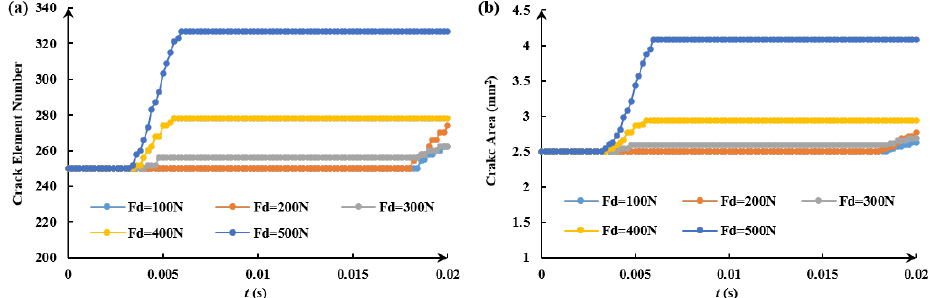
Figure 14. Fracture degree of the crack under different amplitudes of dynamic load: ( a ) crack element number; ( b ) crack area.